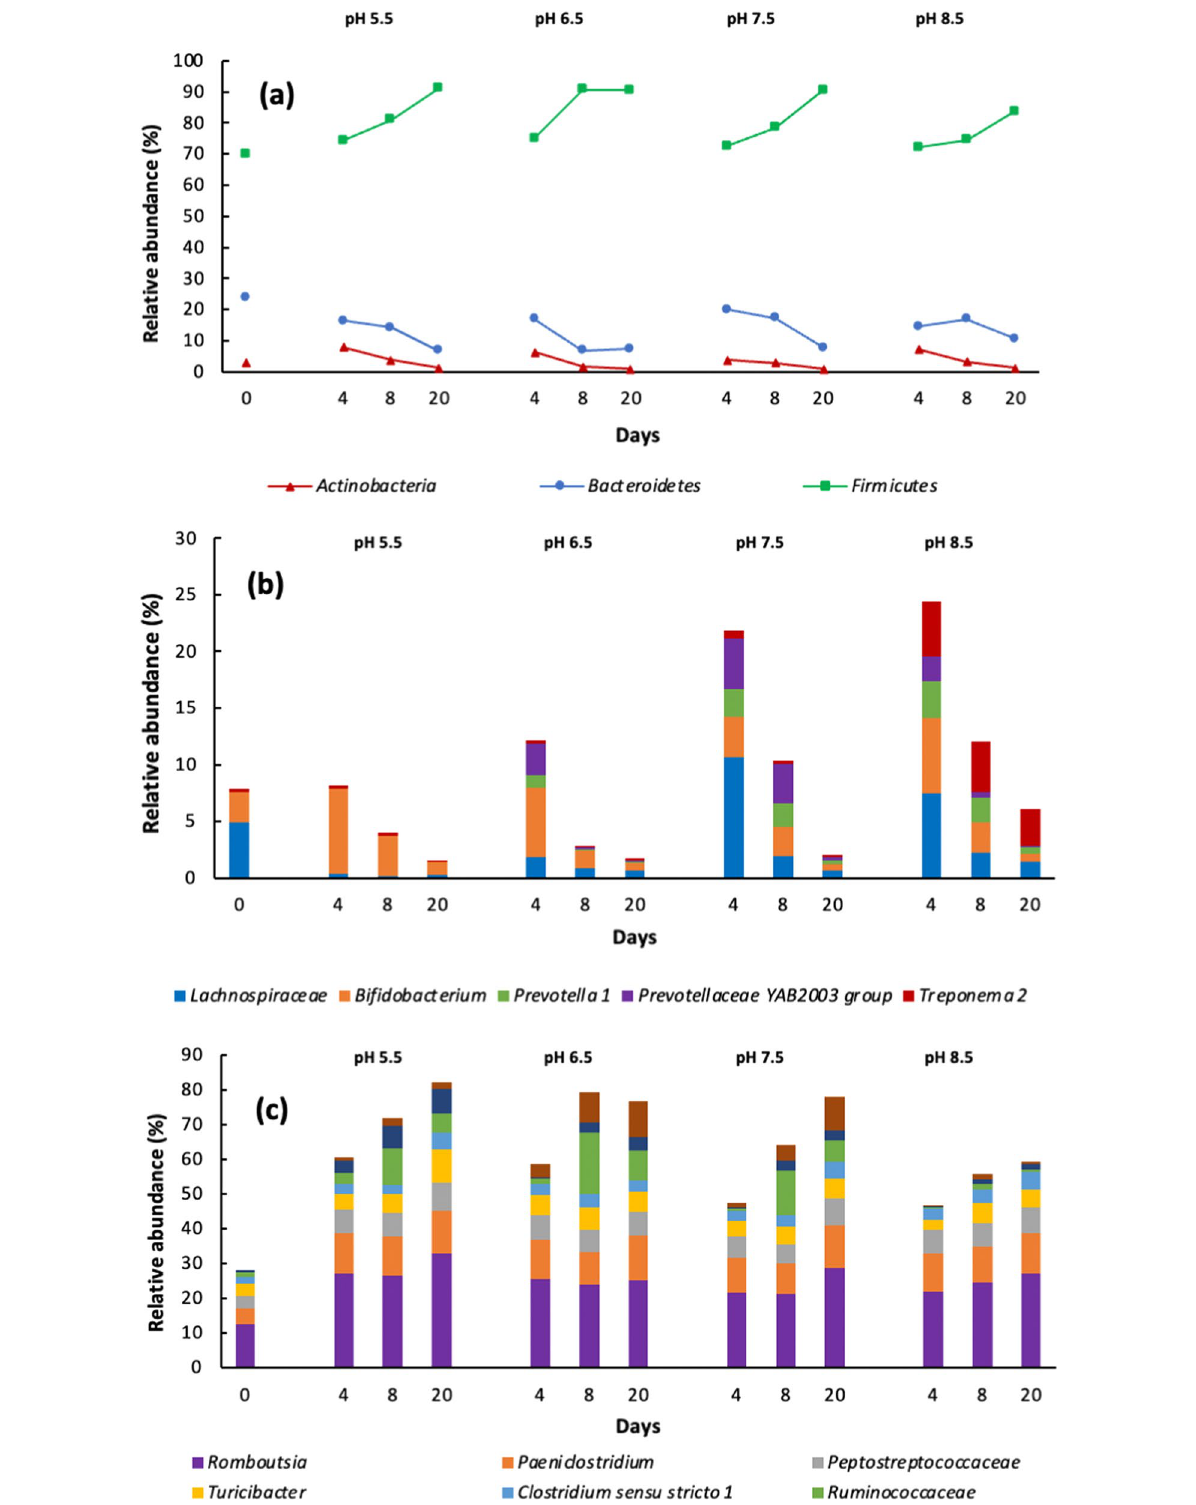
Fig. 1 Dynamics of the relative abundance of the main bacterial taxa during the AD at initial pH 5.5, 6.5, 7.5 and 8.5. a phylum, b microorganisms with maximum growth from 0–4 days, and c microorganisms most abundant during the four